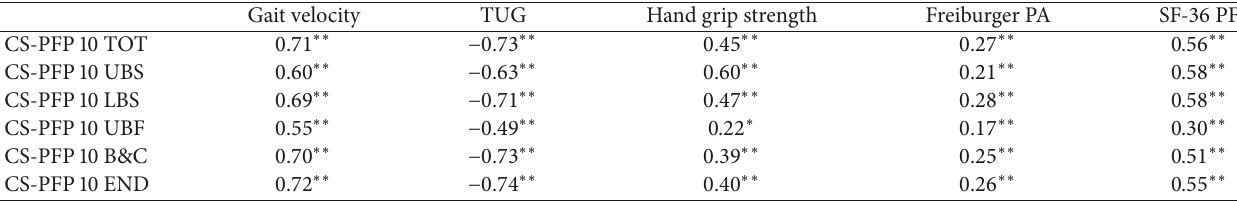
Table 4: Pearson’s product moment correlation.